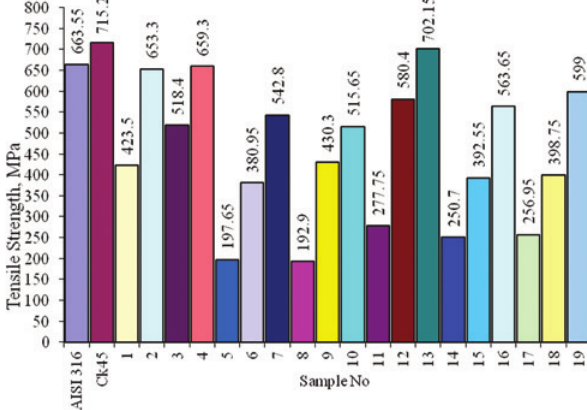
Fig. 10: Average tensile strength values of welded specimens and parent materials